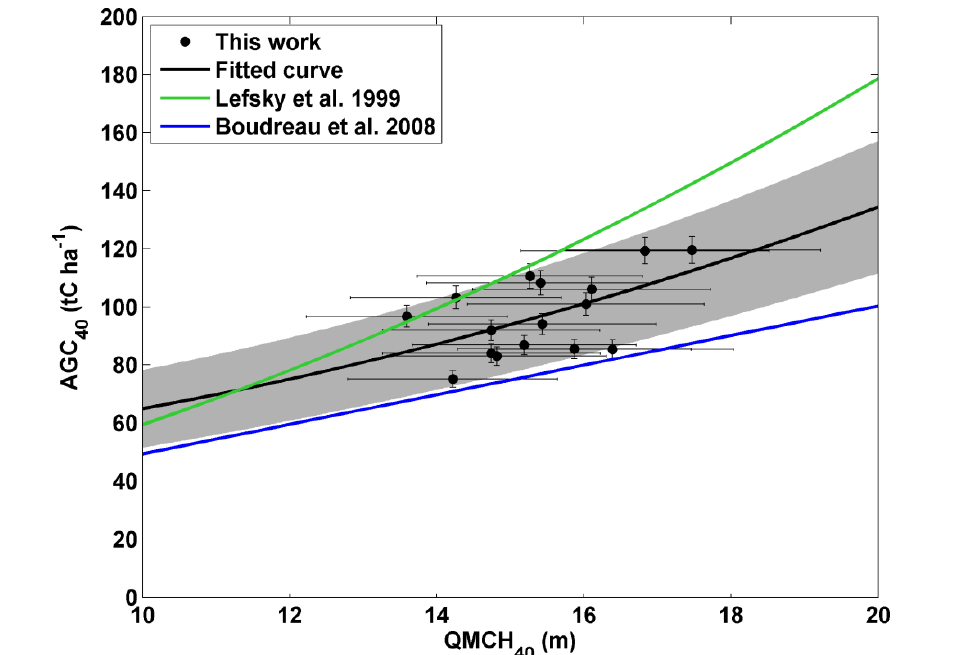
Figure 8. Field-derived plot-level AGC estimated for 16 plots of 40 m × 40 m, plotted against the lidar-derived plot-level QMCH for these plots. The linear regression passing through the points is drawn by a bold line. The uncertainties on the lidar-derived QMCH ( ε ) and field-derived AGC ( ε ) are given as error bars. The uncertainty of the QMCH 40 AGC 40 _field lidar-derived AGC ( ε ) is drawn as the gray area. The relationships published 40 AGC 40 _lidar